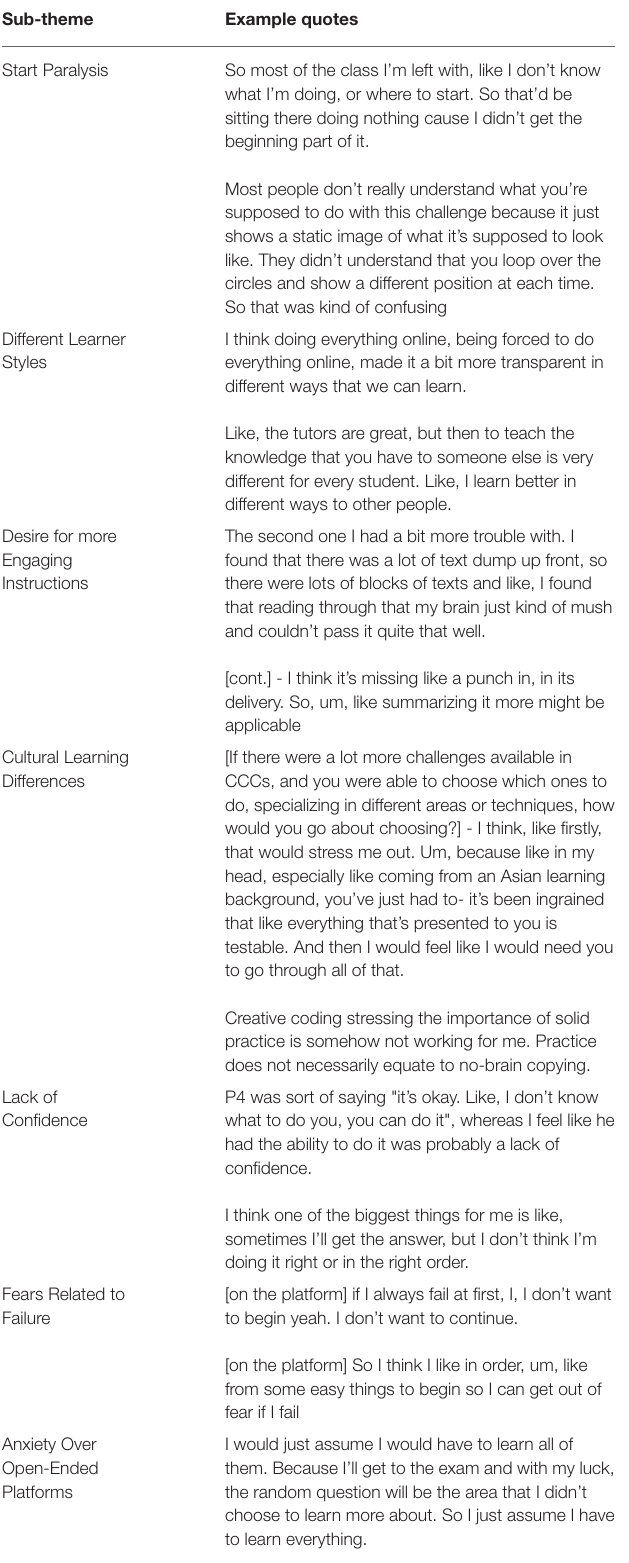
TABLE 7 | Sub-themes within the “Learner Struggles”